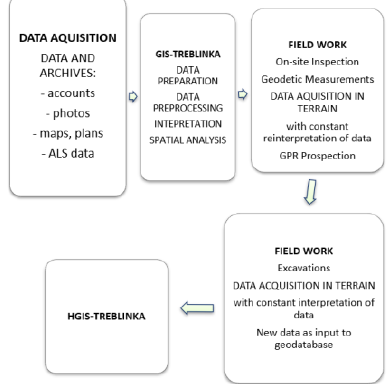
Figure 3. Sequence and elements of the research procedure implemented during the Historical- Geographic Information System (HGIS)-Treblinka project.